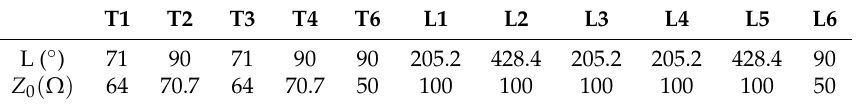
Table 1. Electrical lengths and characteristic impedances of the applied ideal transmission lines. T1 T2 T3 T4 T6 L1 L2